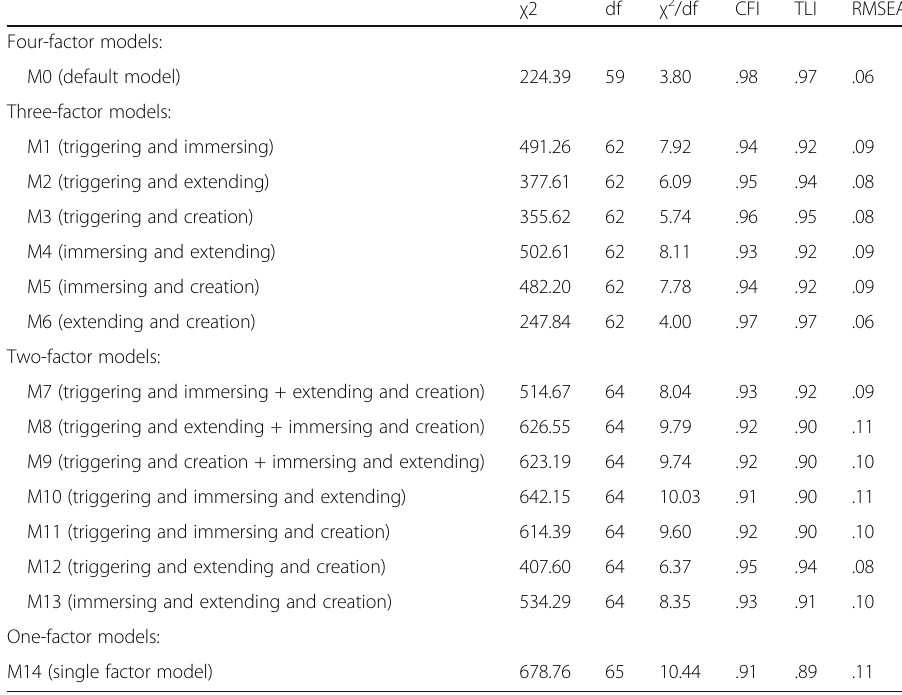
Table 2 Results of competing models of study